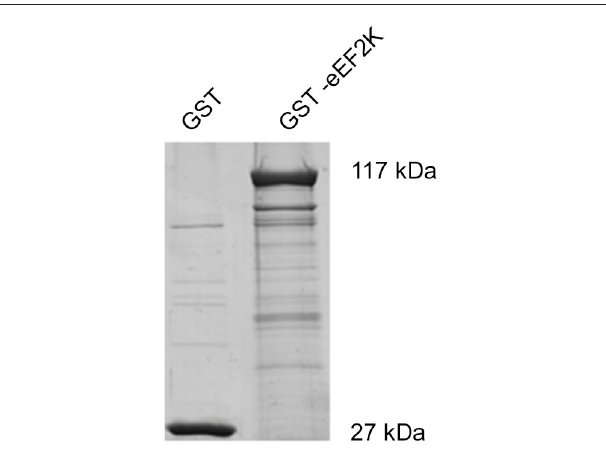
FIGURE 3 | Coomassie Brilliant Blue staining of GST-eEF2K reveals expected molecular weight of fusion protein . eEF2K was expressed as the fusion protein GST-eEF2K (kind gift of Professor Chris G. Proud, University of Southampton) in BL21 competent Escherichia coli and purified as previously described (Tao et al., 2010; Pigott et al., 2012; Pyr Dit Ruys et al., 2012). After SDS-PAGE, gels were stained with Coomassie Brilliant